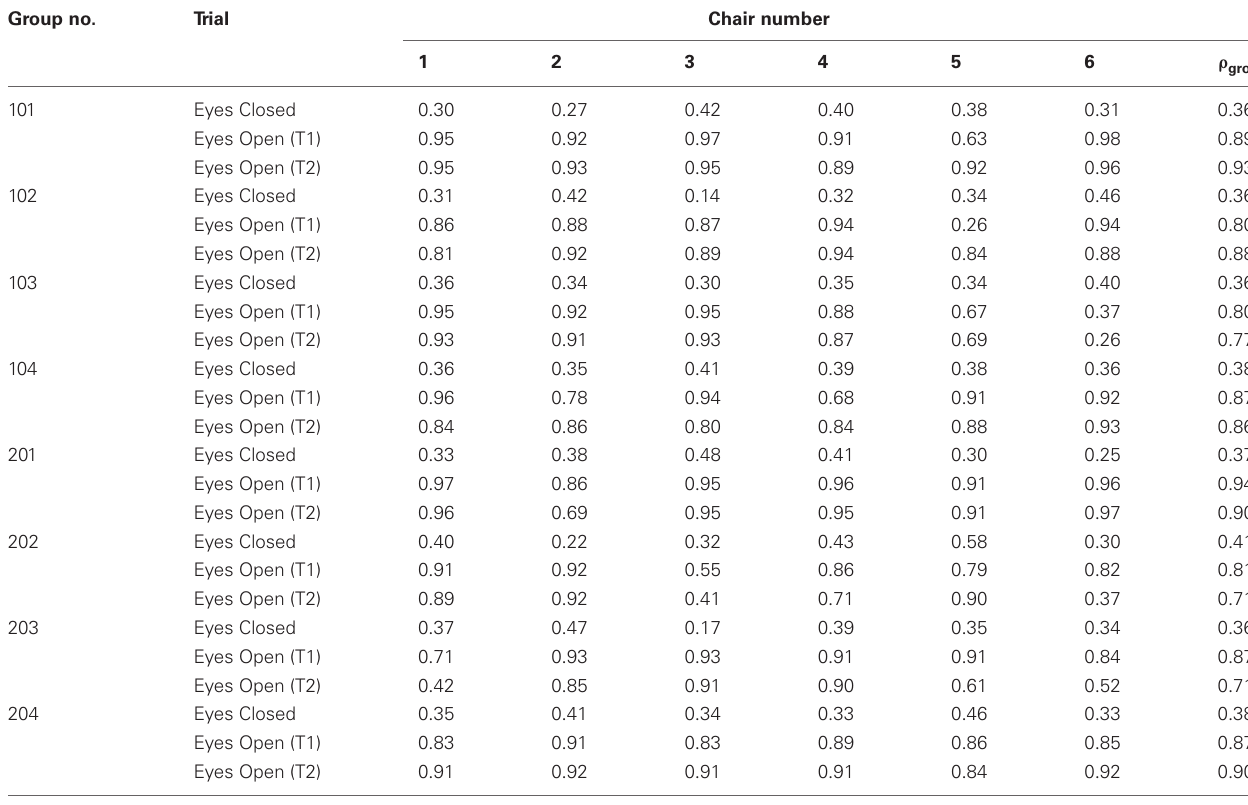
Table 2 | Individual ( ρ k ) and group ( ρ group ) cluster amplitudes. Group no.